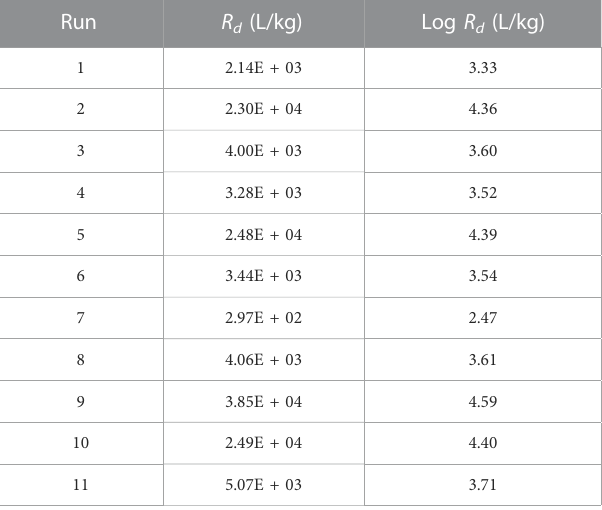
TABLE 5 R d values for the 11 experiments of the P.-B. design for screening of active factors. Run